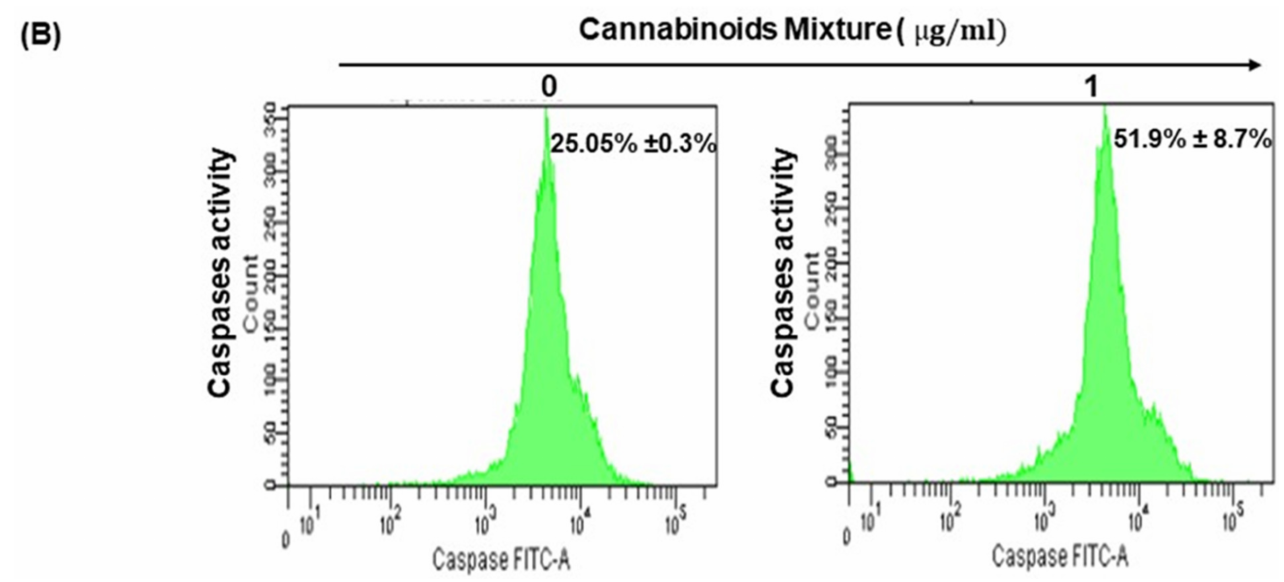
Figure 5. CM promotes apoptosis in Ca9-22 cells. ( A ) Flow cytometry assay using Annexin V and PI to measure apoptotic cell death in oral cancer cells after treatment with 1 µ g/mL of CM ( n = 3), without or with 10 mM of NAC or 50 µ M of 3-MA. ( B ) Activation of caspases by CM in Ca9-22 cells detected by flow